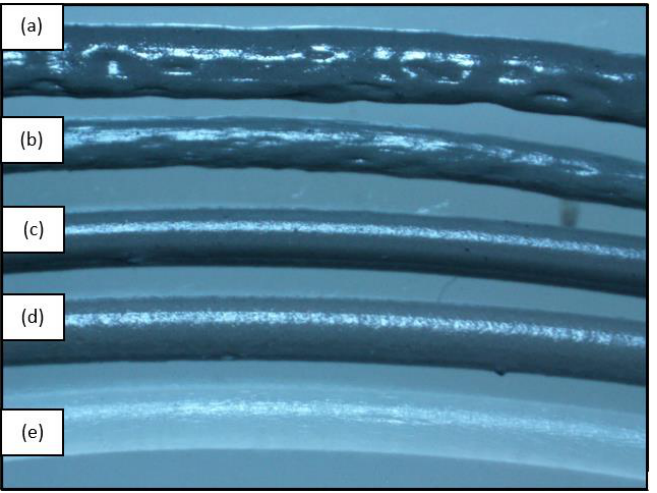
Figure 11. Extruded filament ( a ) rPP; ( b ) rPP + 2.5%; ( c ) rPP + 5%; ( d ) rPP + 10%; and ( e ) PP.